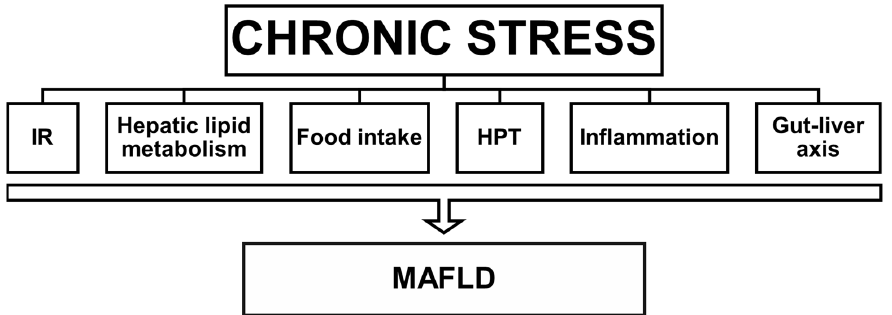
Figure 1. Major potential multiple roles of psychosocial chronic stress in MAFLD. Chronic activation of the stress response leads to high GC levels that exert multiple effects related to MAFLD development. GCs induce insulin resistance (IR) and affect hepatic lipid metabolism by increasing fat delivery from the adipose tissue to the liver, where de novo lipogenesis is stimulated whilst fat utilization and secretion are diminished. Chronic stress stimulates the intake of energy-dense food and decreases the functionality of the HPT axis, thus decreasing metabolic rate and energy expenditure. By means of different mechanisms that include GC resistance, chronic stress enhances inflammation, which is also related to induced gut dysbiosis and leaky gut (gut–liver axis).